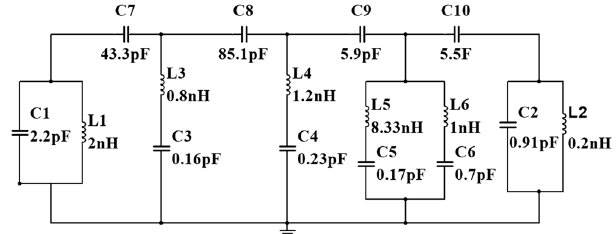
Figure 7. Equivalent circuit of the proposed MTM unit